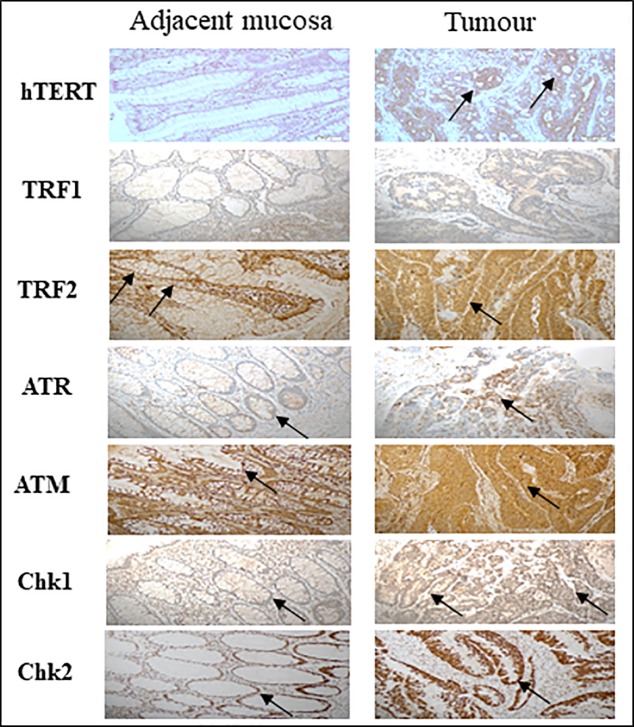
Immunohistochemical staining for TRF1, TRF2, ATR, ATM, Chk1 and Chk2 in paraffin-embedded colorectal carcinoma and adjacent mucosa.Abundant expression of hTERT, TRF2, ATR, ATM and Chk2 were observed in CRC tissue compared to adjacent mucosa validating the q-PCR results. No difference was detected in TRF1 protein level between the cancerous tissue and adjacent mucosa.